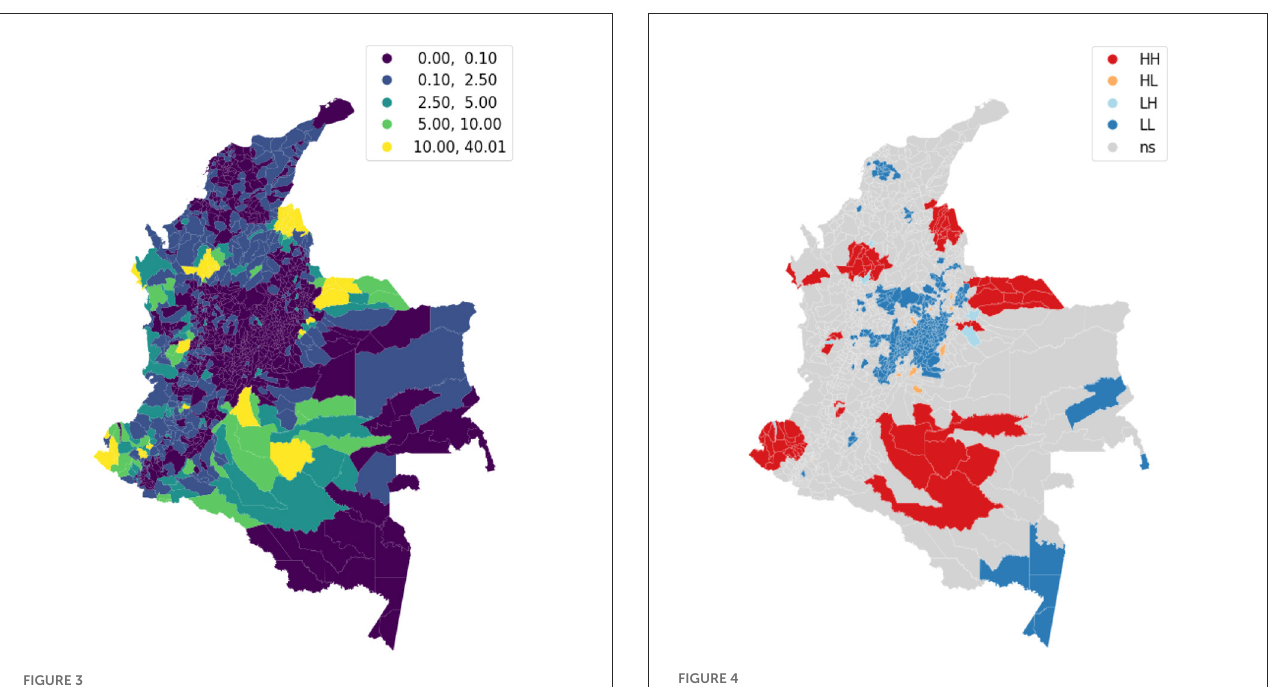
FIGURE3 Distribution of violent events in 2018, per 10,000 inhabitants, by the municipality.